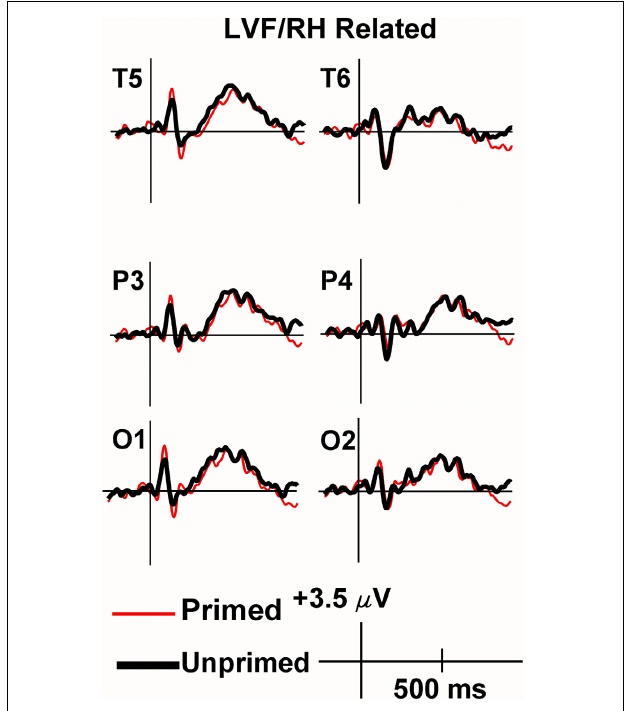
FIGURE 6 | Grand average ERPs recorded to non-synonymously related targets presented to the LVF/RH. There were no significant inhibition or facilitation